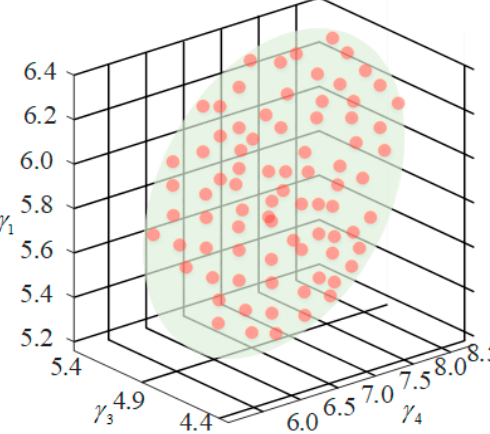
Figure 5. Correlations of uncertainties.